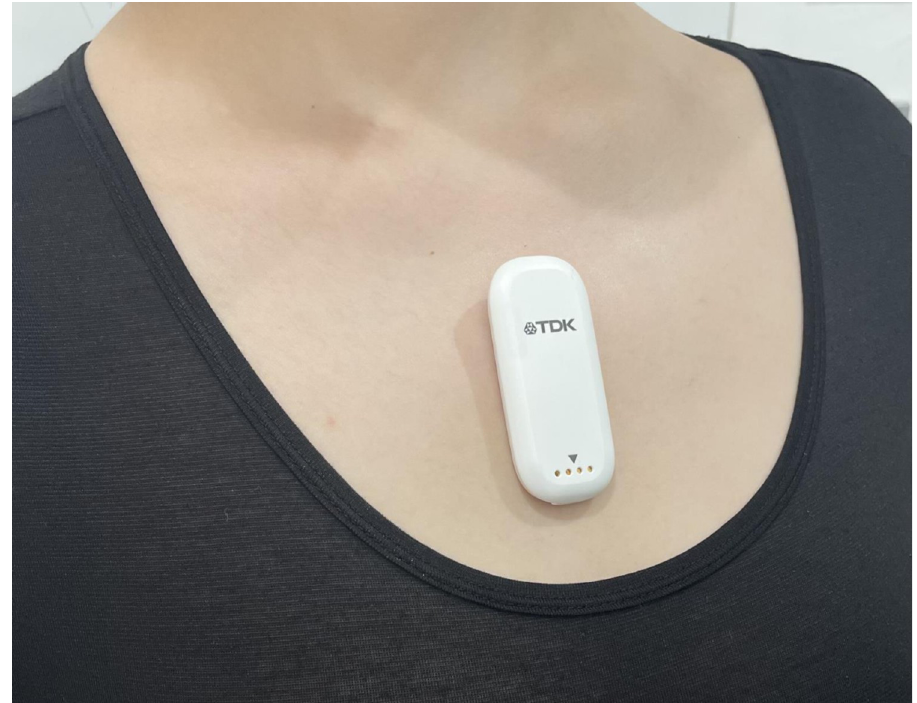
Fig 1. The Silmee ™ Bar type Lite (TDK, Tokyo, Japan) device. This biosensor automatically calculates heartbeat intervals, pulse wave intervals, and autonomic nerve activity by measuring and analyzing electrocardiograms, pulse waves, acceleration, and/or skin